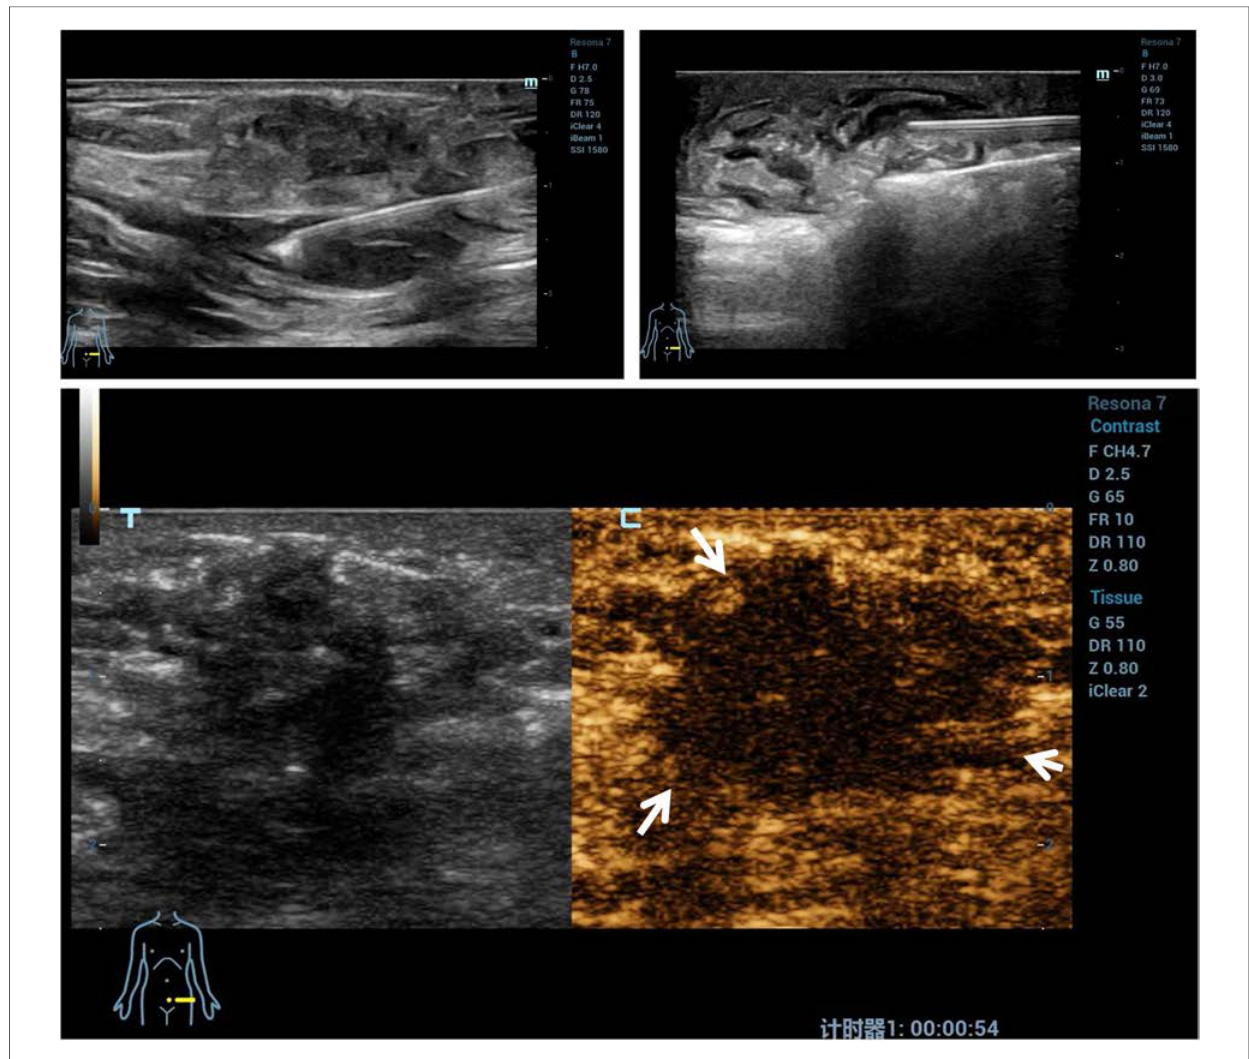
FIGURE 3 A representative case of microwave ablation treatment. Microwave ablation was performed, and a gasi fi cation reaction of the hyperechoic cloud was observed inside the lesion region. The contrast-enhanced ultrasound imaging of AWE nodules shows no contrast agent fi lling in the nodules. AWE, abdominal wall